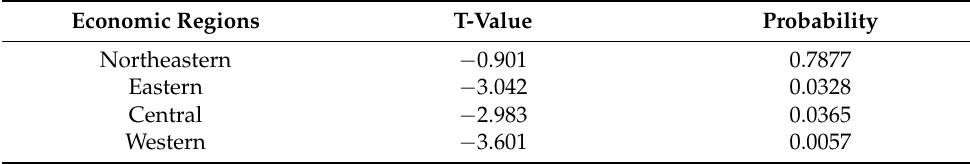
Table 4. ADF test results of the residual series of the four economic